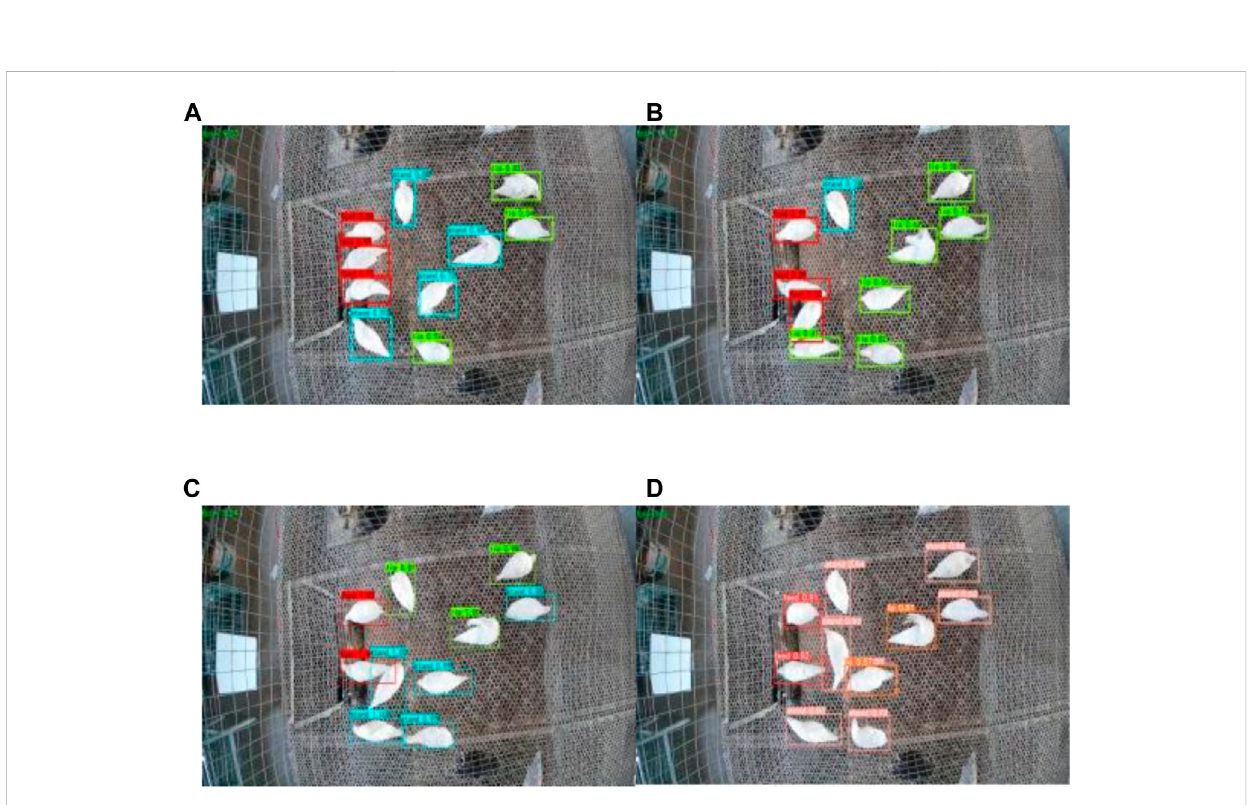
YoloV5 are 91.34% and 98.15%, respectively, higher than the tested values of the other three detection algorithms for this behavior of lying. Experiments with the same size data set and experimental equipment showed that YoloV5 and Faster-RCNN were able to accurately identify various types of laying hens ’